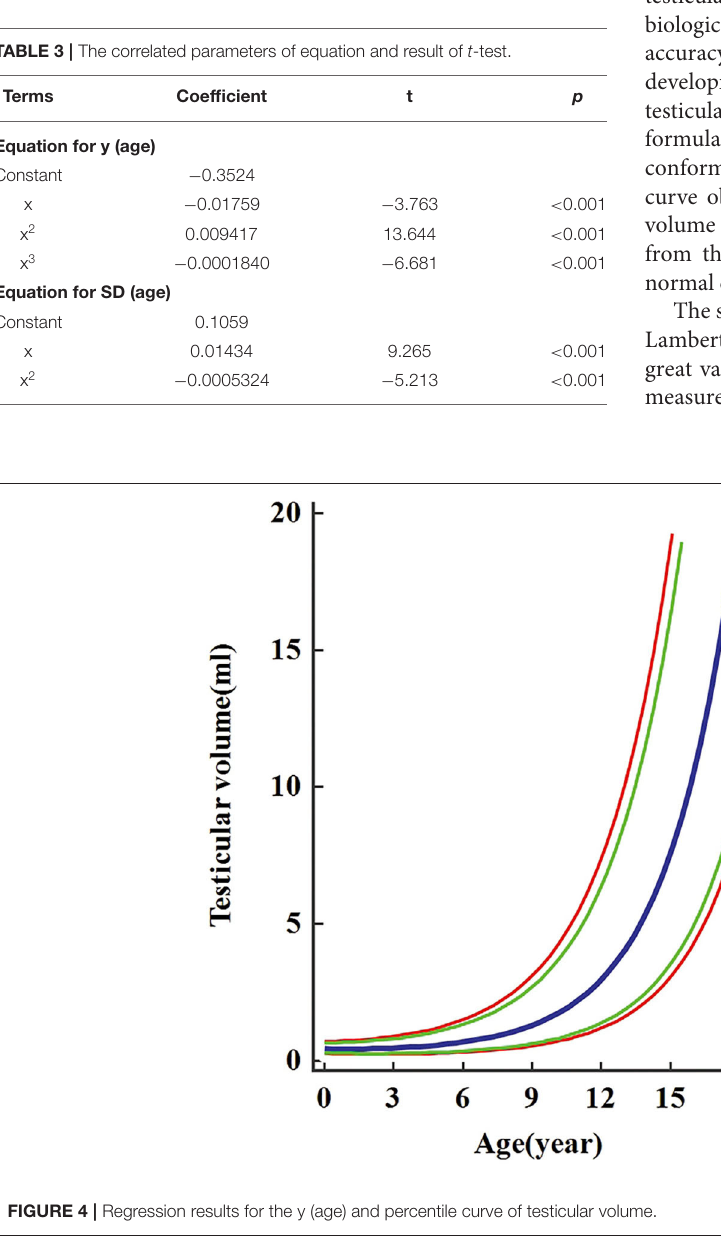
Frontiers in Pediatrics |